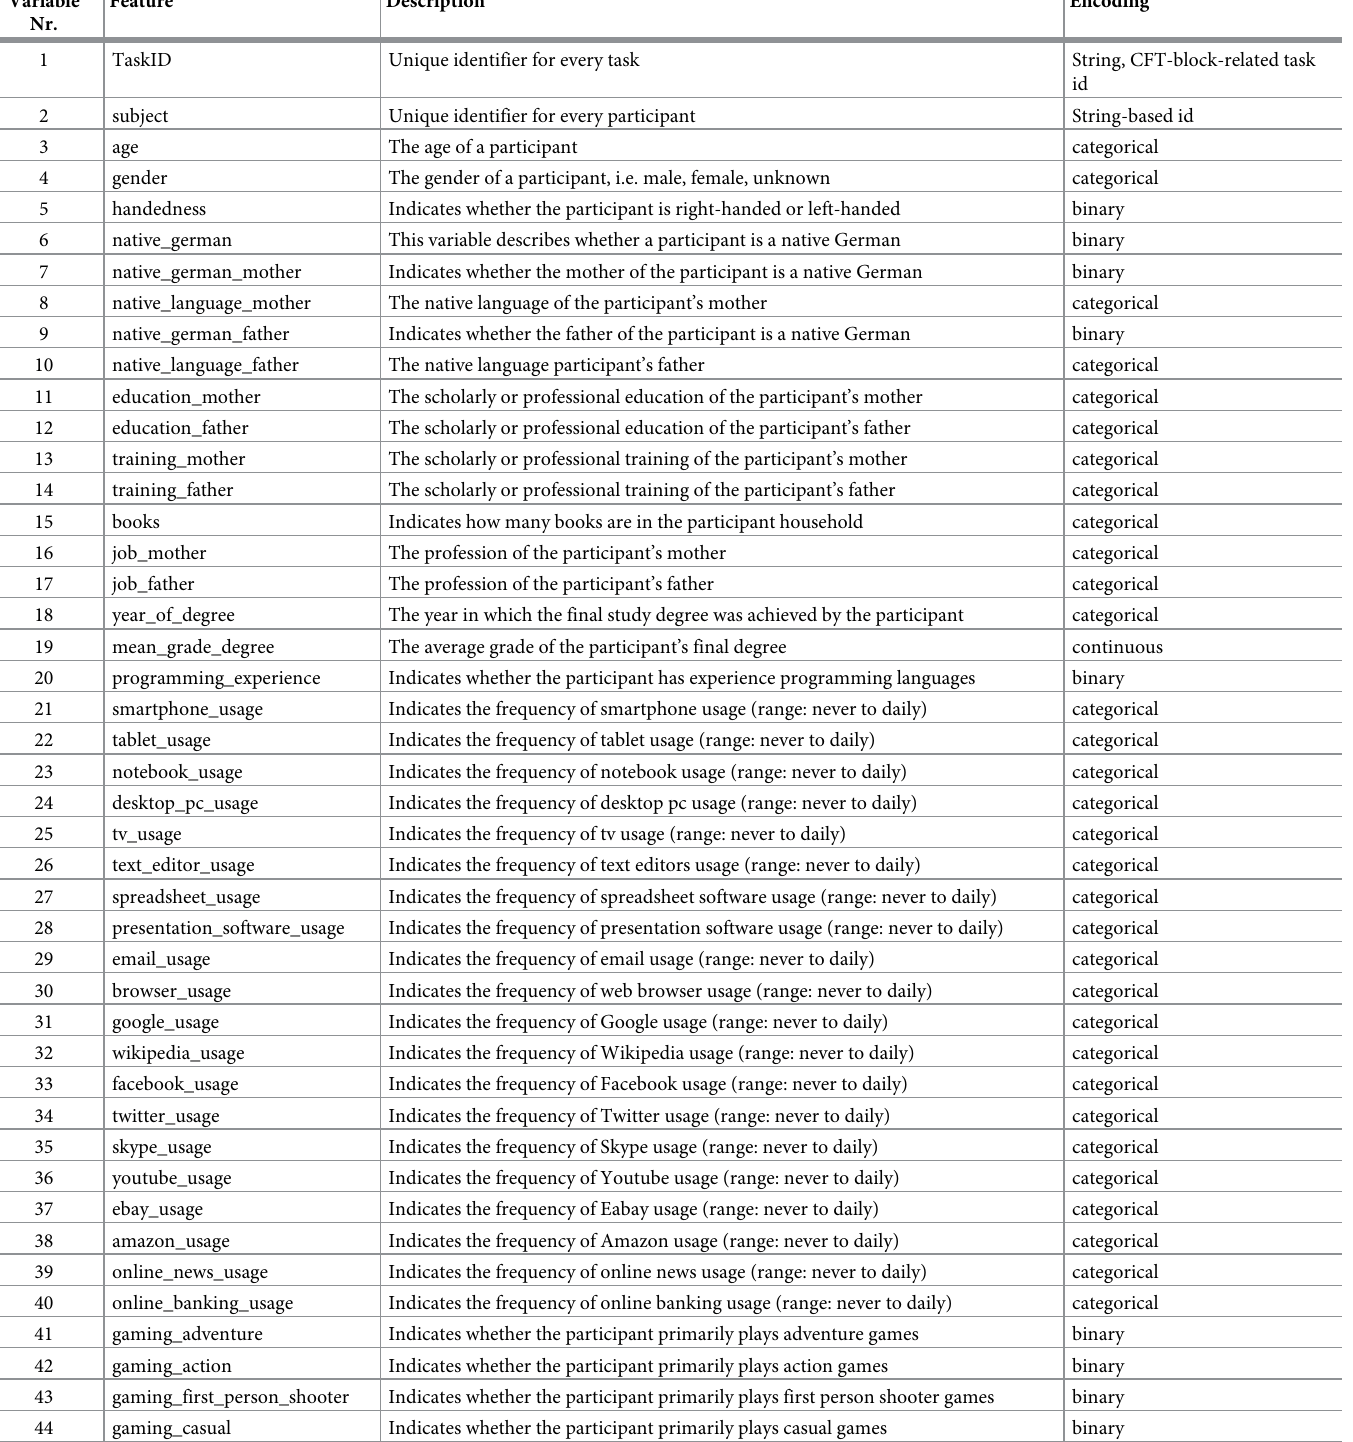
Table 1. Description and encoding of all performance-related, educational and socio-demographic features in the order of their appearance in the csv file as pro- vided by the Tu¨EyeQ data set (available through the Harvard Dataverse Repository under https://doi.org/10.7910/DVN/JGOCKI). Variable